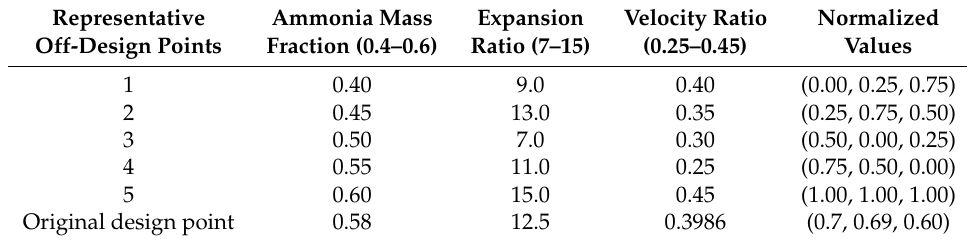
Table 5. Representative off-design